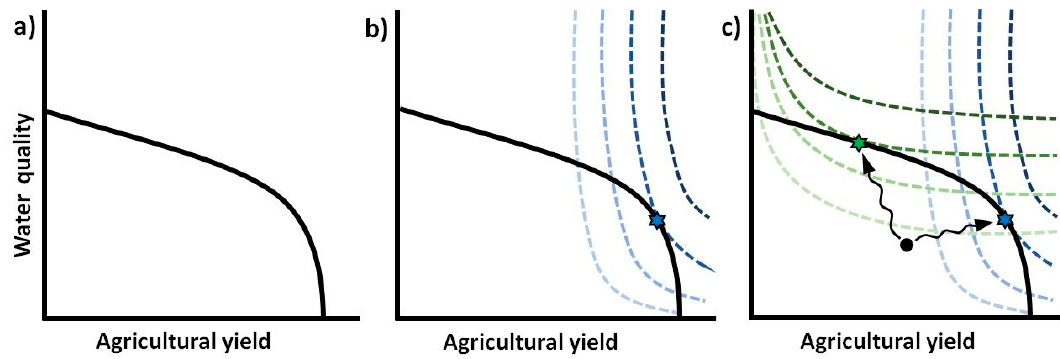
Figure 3. Illustrating the trade-off between water quality and agricultural yield using a production possibility frontier (PPF; black line, ( a )), and the utility functions of two stakeholders with differing values (shades of green or blue dotted lines ( b )). The blue star illustrates the ideal balance of the trade-off for upstream farmers, whereas the green star shows the preferences of downstream stakeholders, who are impacted by lowered water quality, such as people who use or manage downstream bathing waters ( c ). Reproduced from [King et al.], [Ecology and Society], (2015), [52].